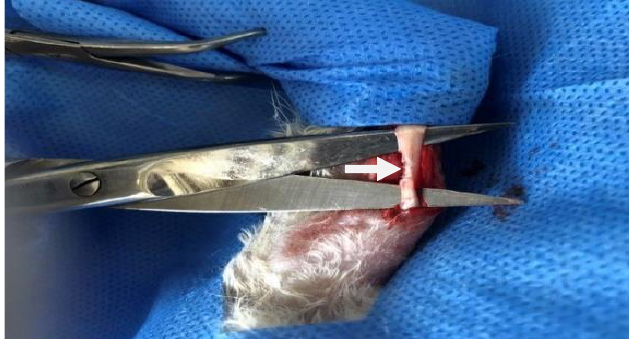
Figure 1 . A representative photograph showing the site of tendon injury (white arrow)